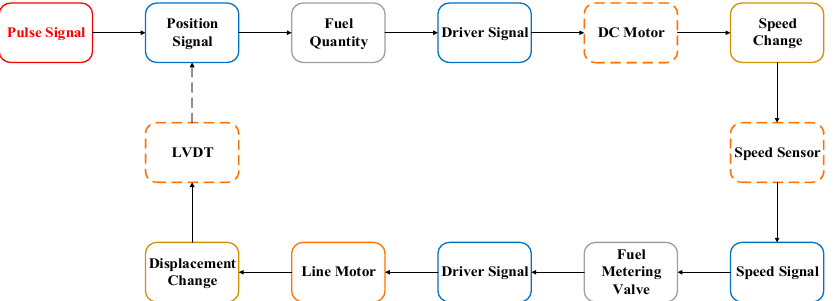
Figure 10. Interference path of the main fuel regulation control system.